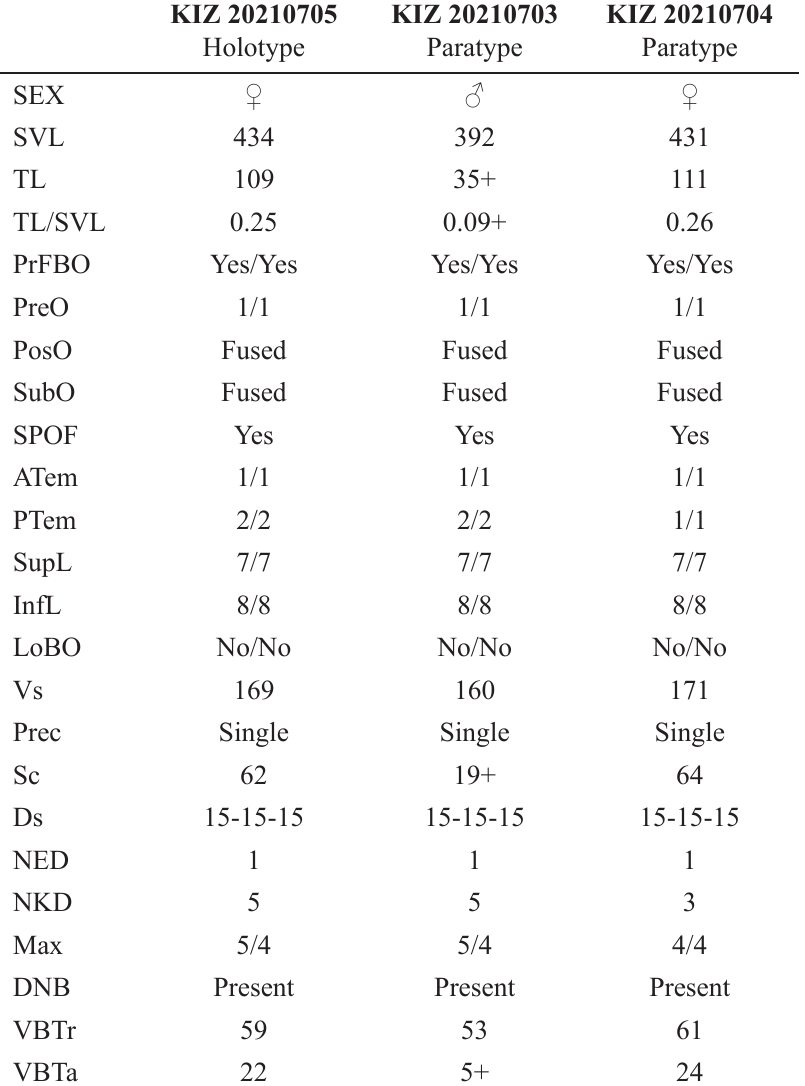
Table 5. Morphological characters of the type series of Pareas tigerinus sp. nov. For abbreviations, see Material and methods section. Measurements in mm, paired meristic characters given as